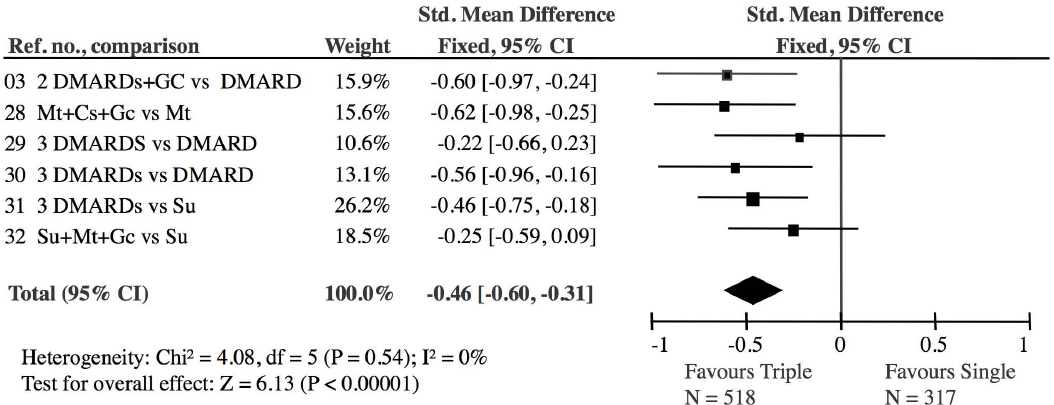
Figure 5. Triple DMARD versus single DMARD: The effect of the Triple DMARD treatment was highly significant (Z=6.13). The 6 Triple studies showed no heterogeneity (I 2